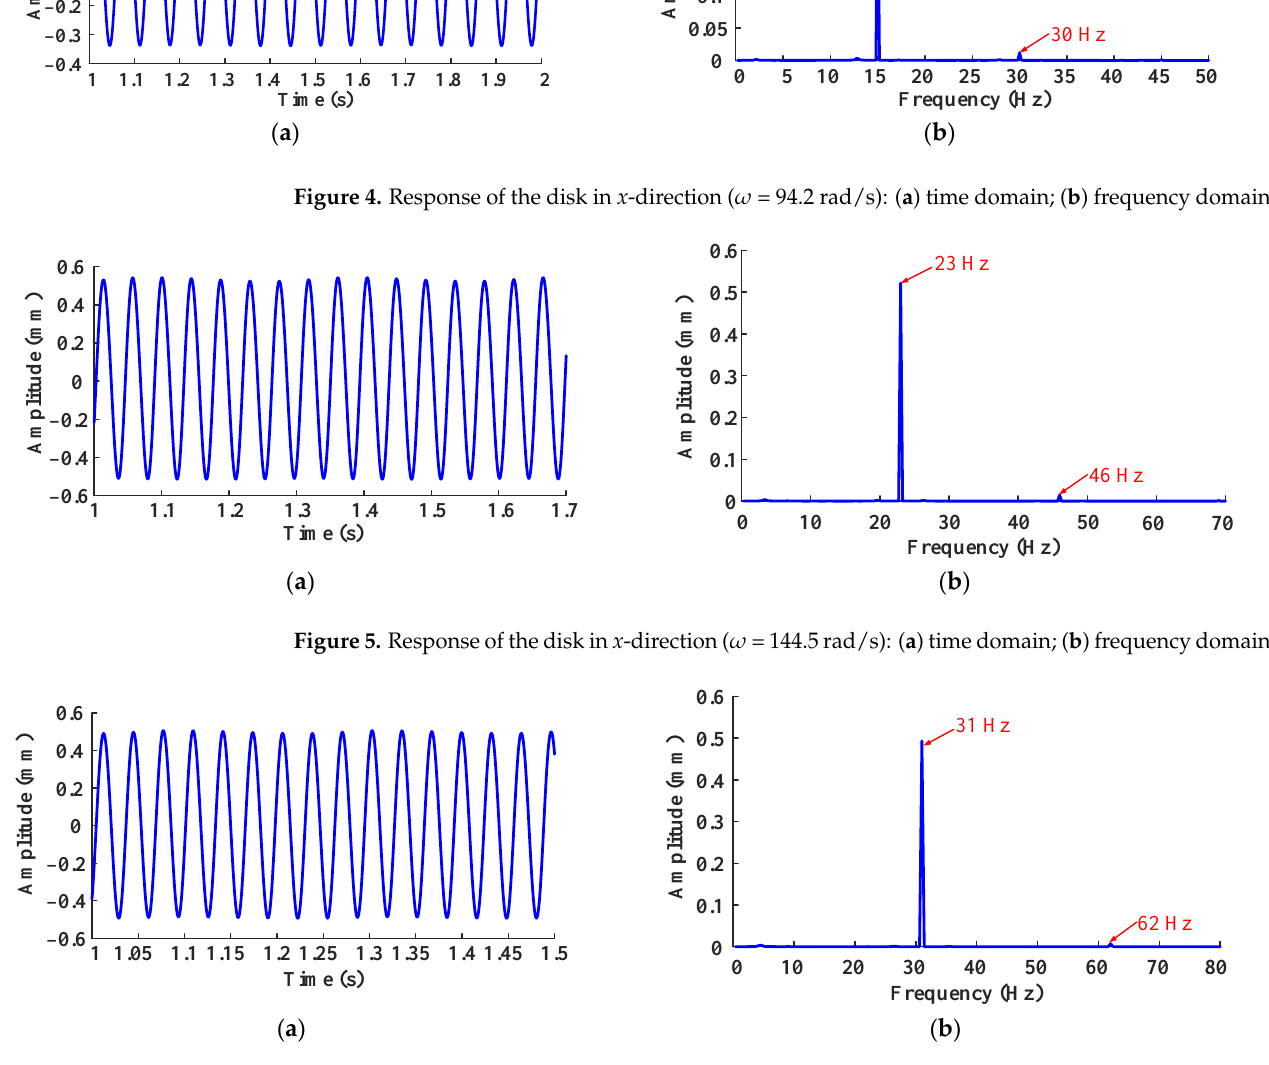
Figure 6. Response of the disk in x -direction ( ω = 250 rad/s): ( a ) time domain; ( b ) frequency